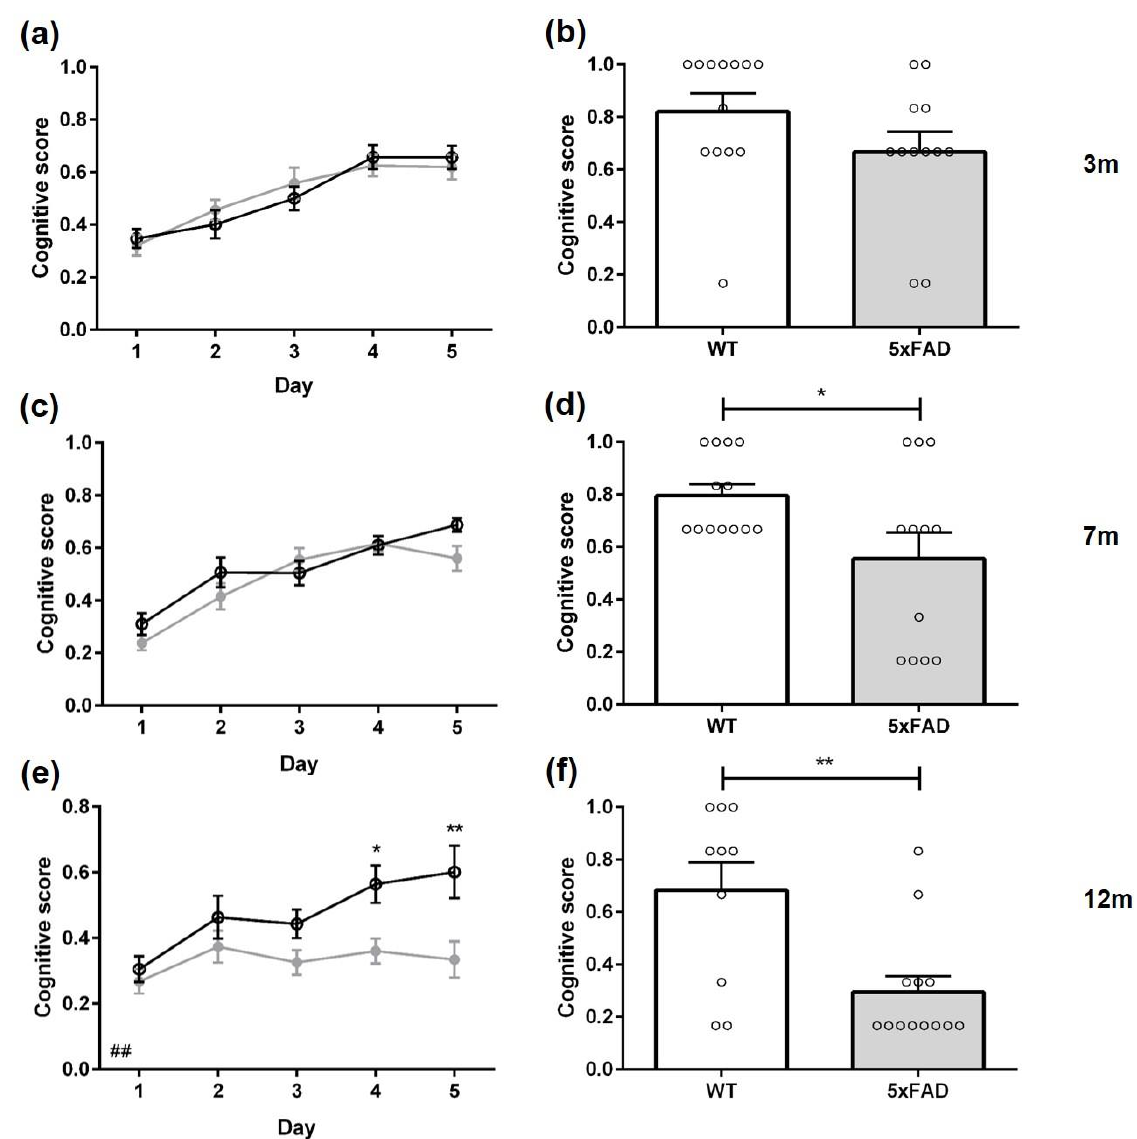
Figure 9. Cognitive scores of male 5xFAD mice. The cognitive scores of 5xFAD mice decreased age-dependently in the acquisition training ( a , c , e ) and the probe trial ( b , d , f ). Data presented as mean ± S.E.M., n = 10–13. Acquisition training: two-way repeated measures analysis of variance (ANOVA) followed by Bonferroni multiple comparisons. ANOVA: ## p < 0.01; Bonferroni: * p < 0.05, ** p < 0.01. Probe trial: unpaired t -test: * p < 0.05, ** p < 0.01.